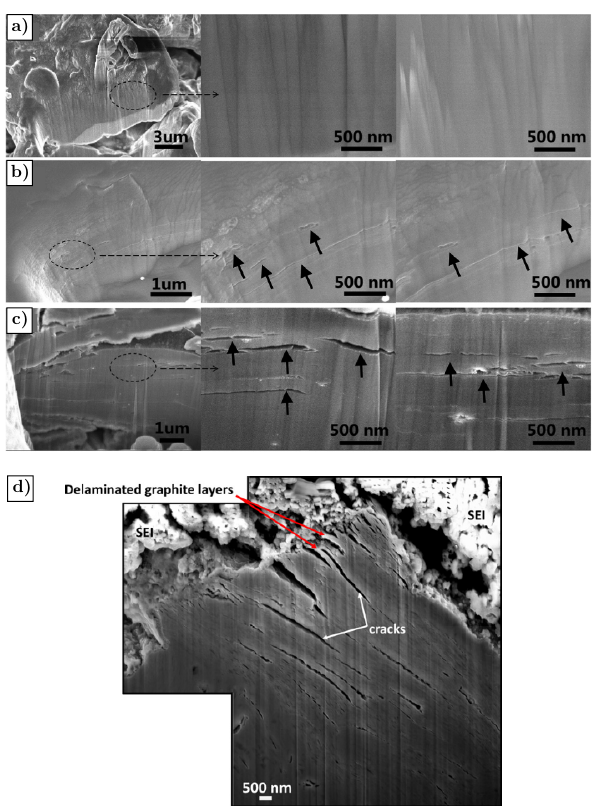
Figure 3. Cross-sectional SEM image of the ( a ) pristine graphite and graphite particles from cells cycled at 1C for ( b ) 200 and ( c ) 800 cycles. Black arrows point to the cracks. Reproduced with permission from Elsevier from [40], Copyright 2017. ( d ) Cross-section SEM image of graphite particle and SEI layer; parallel cracks may cause delamination. Reproduced with permission from Elsevier from [45], Copyright